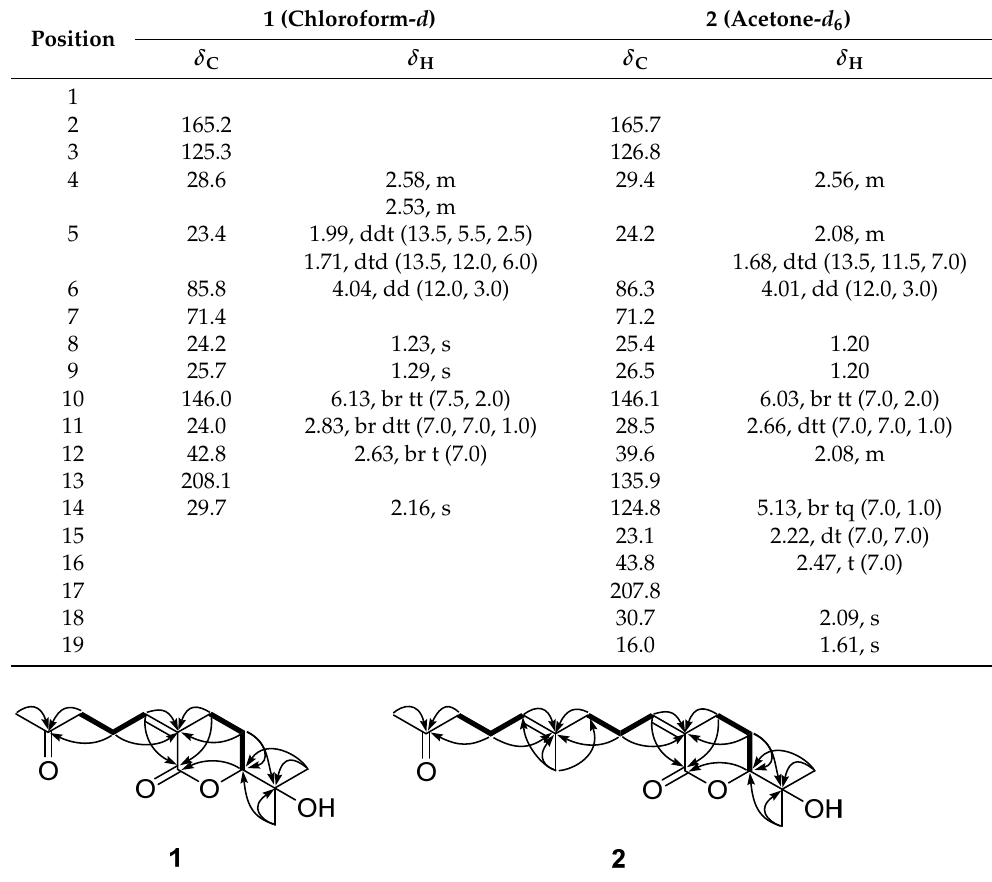
Figure 2. Key correlation spectroscopy (–) and heteronuclear multiple bond correlation ( → ) correla- tions of compounds 1 and 2 .